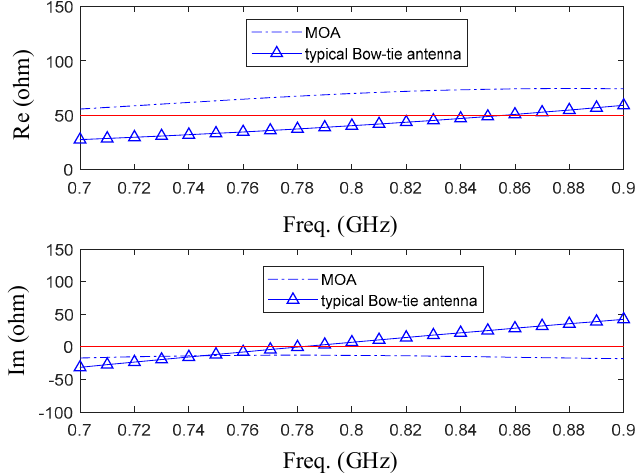
Figure 9. This picture shows the simulated impedance for typical Bow-tie antenna and modified antenna. Compared with the typical antenna, the imaginary part of input impedance of the MOA has been closer to 0.